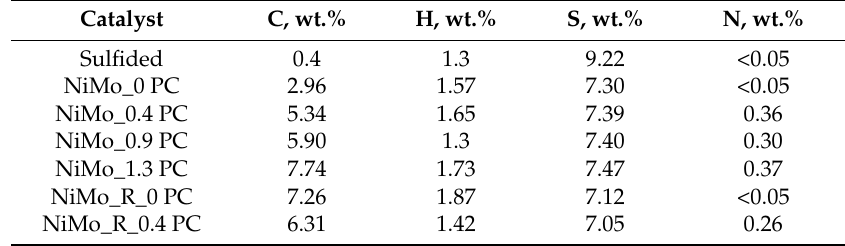
Table 3. Elemental contents of carbon, hydrogen, sulfur, and nitrogen on the freshly sulfided and recovered catalyst samples.